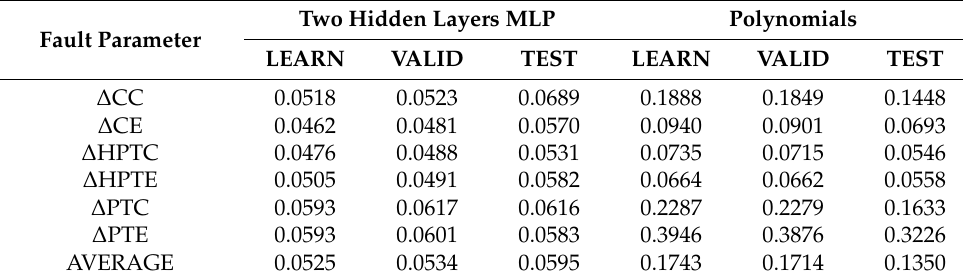
Table 7. Fault parameter RMSE of polynomials and MLP.